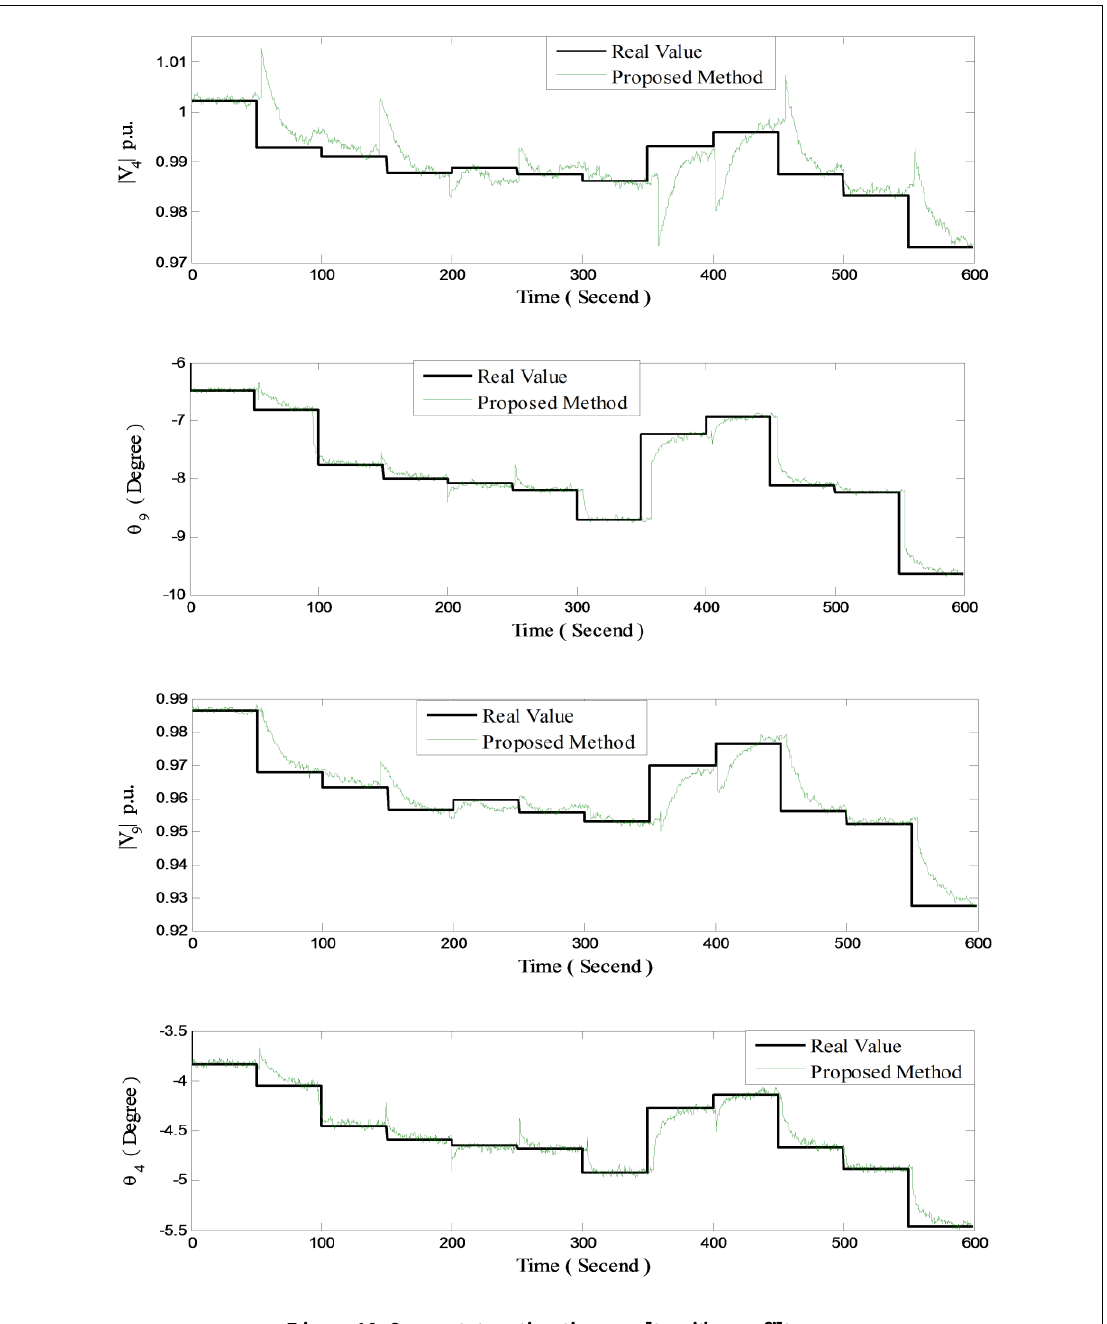
Figure 10. Some state estimation results with